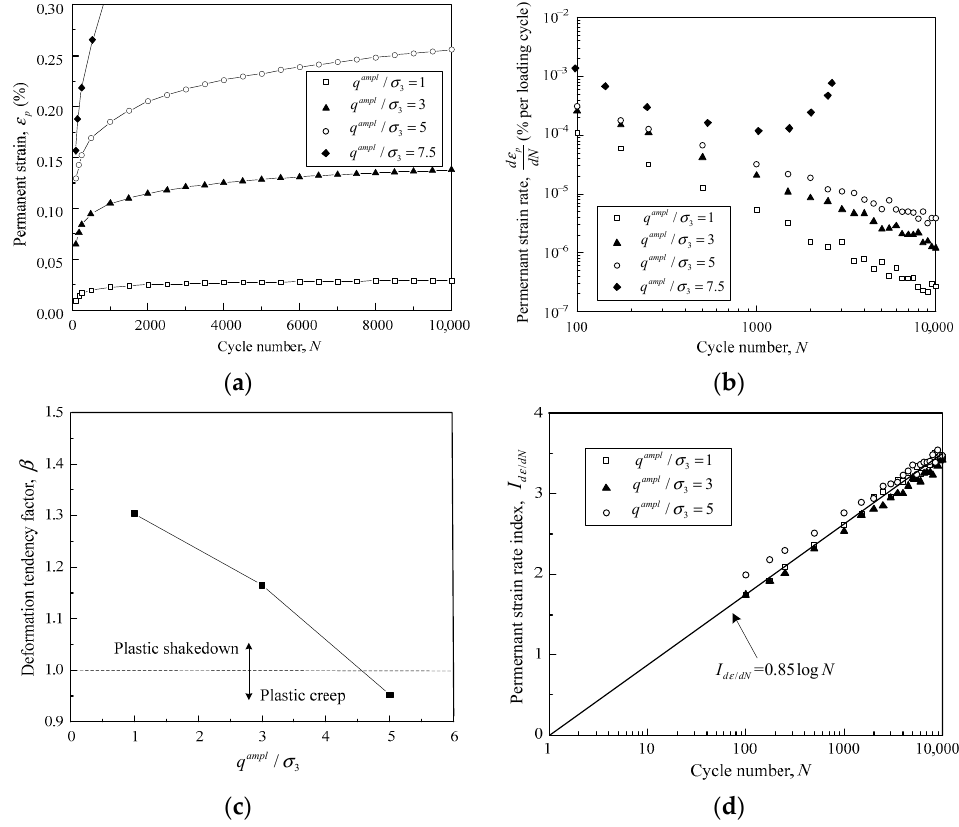
Figure 13. Permanent deformation properties of crushed tuff aggregates at saturated water content: ( a ) the relationship between permanent strain and loading cycles; ( b ) permanent strain rate plotted against loading cycles in double-log coordinate; ( c ) development of deformation tendency factor β against cyclic amplitude; ( d ) normalized strain rate curves under different cyclic amplitudes. (Data calculated from Cao et al., 2017) [7].